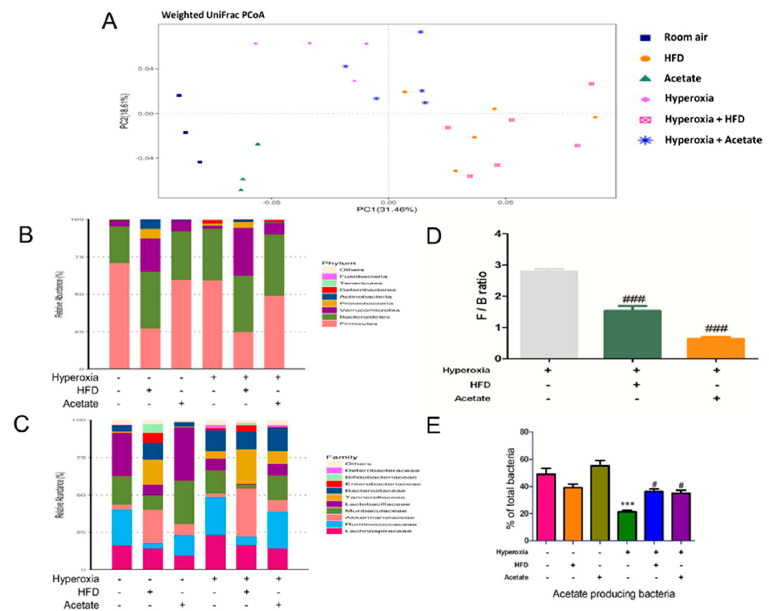
Figure 2. A high-fiber diet and acetate supplementation alter the composition of the gut microbial community. The composition of the gut microbiota was significantly different between ambient air and hyperoxia-exposed mice and the mice in the control, high fiber diet (HFD), or acetate-supplemented groups. Unweighted UniFrac principal coordinate analysis results are shown ( A , PCoA, p < 0.001). Percentage of total bacteria at the phylum ( B ) and family ( C ) levels is presented. The Firmicutes to Bacteroidetes (F/B) ratio, an indicator of gut dysbiosis, was lower in the HFD group and acetate-supplemented group ( D , p < 0.01). The HFD group and acetate-supplemented group had significantly higher abundances of acetate-producing bacteria ( E , p < 0.05). Data are mean ± SD (three mice per group). *** p < 0.001, compared with the ambient air group; # p < 0.05, ### p < 0.001 compared with the hyperoxia group.